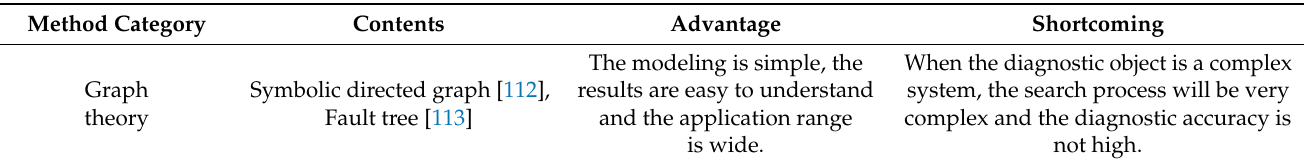
Table 2. Summary and analysis of existing fault diagnosis methods.